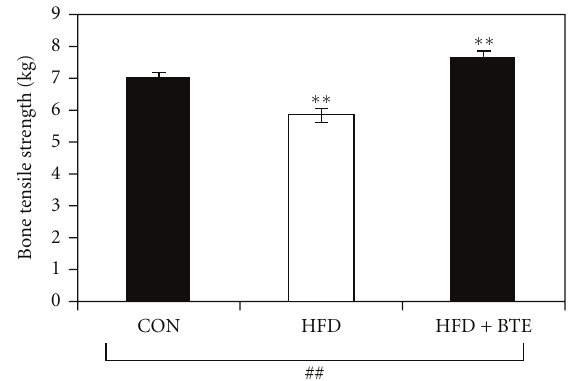
Figure 1: Graphical presentation of bone tensile strength of control (CON; Group A), HFD (Group B), and HFD + BTE supplemented (Group C) groups of animals. Values are expressed as mean ± S.E.M. ( n = 6). ## P < . 01 denotes significance based on Kruskal- Wallis non-parametric ANOVA test, ∗∗ P < . 01 denotes significance based on Mann-Whitney “U” multiple comparison test.